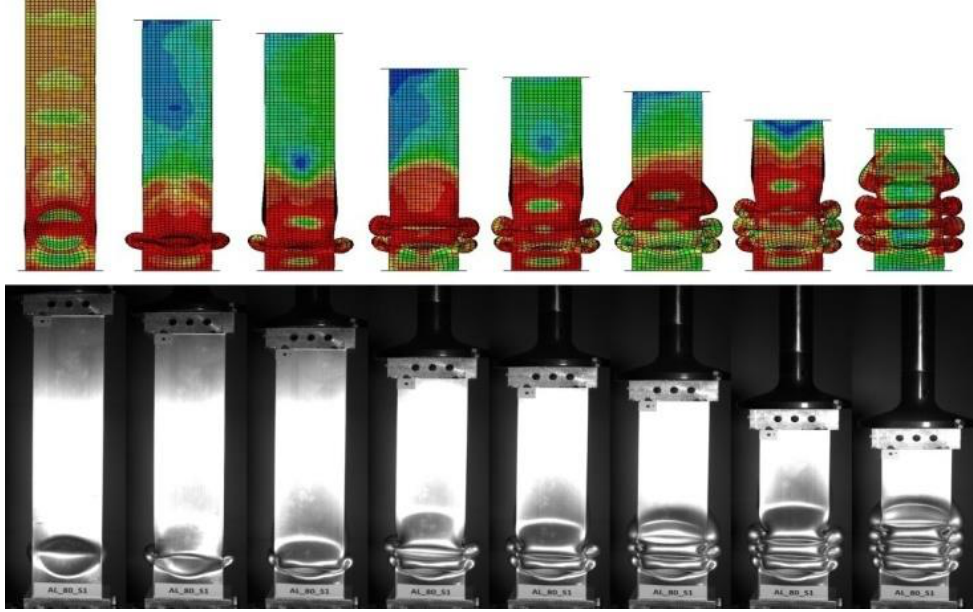
Figure 12. Comparison form of crushed absorber in different stages of dynamic analysis for 80 mm length foam.